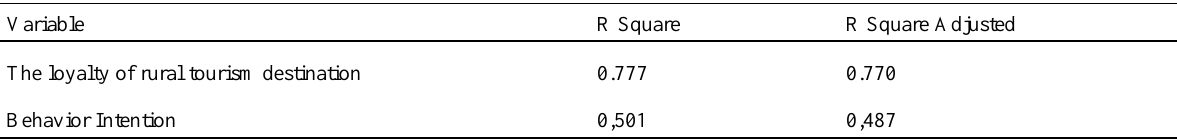
Table 3: R Square